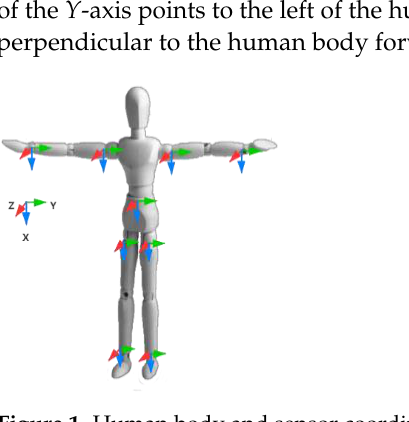
Figure 1. Human body and sensor coordinate system based on bone nodes.